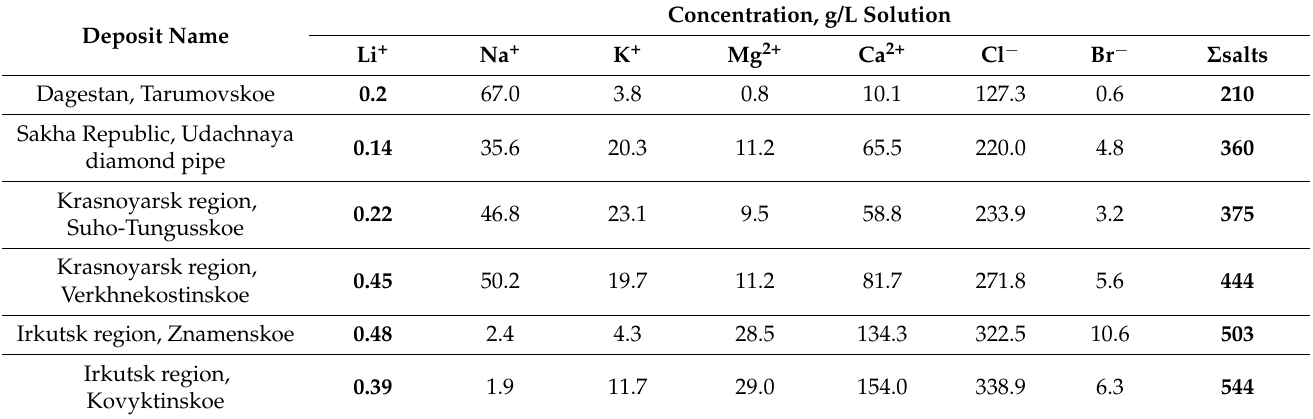
Table 1. Composition of several lithium-rich geothermal brines in Russia